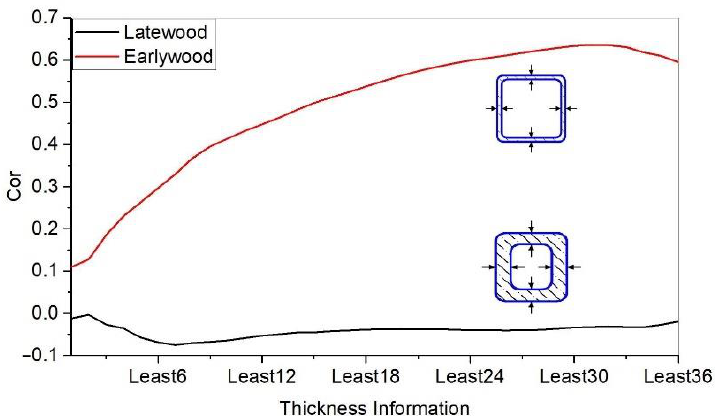
Figure 12. The correlation coefficient between yield force and the thickness data of the cell walls of earlywood and latewood.